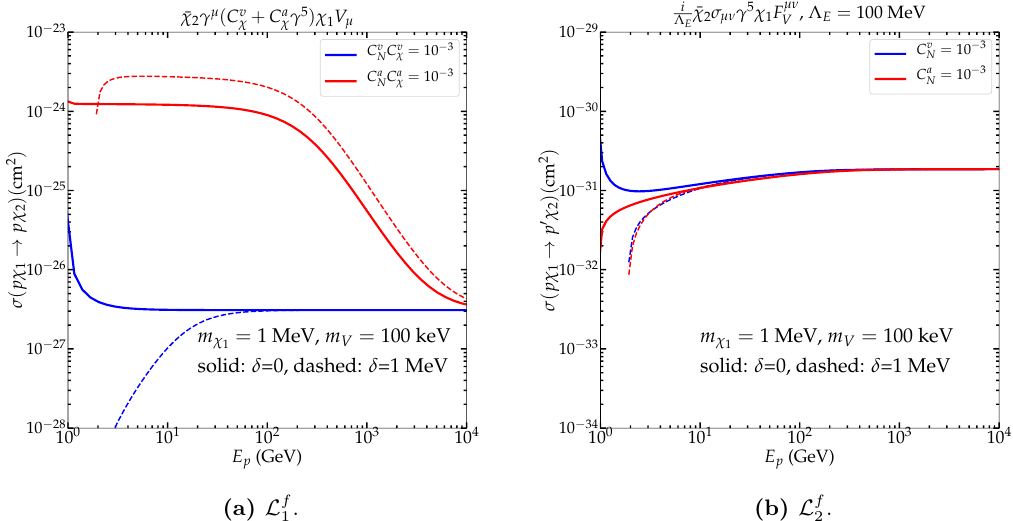
Figure 2. The integrated cross section of process pχ 1 → p 0 χ 2 as a function of incoming proton energy E . We used red and blue lines to denote C v p the elastic scenario (solid lines), we also present δ = 1 MeV as dashed lines. The AA interaction ( C v = C v = 0 ) has a greater cross section than VV one ( C a χ N illustrated by ED, the resulting difference between the vector interaction and axial vector interaction of L is V N